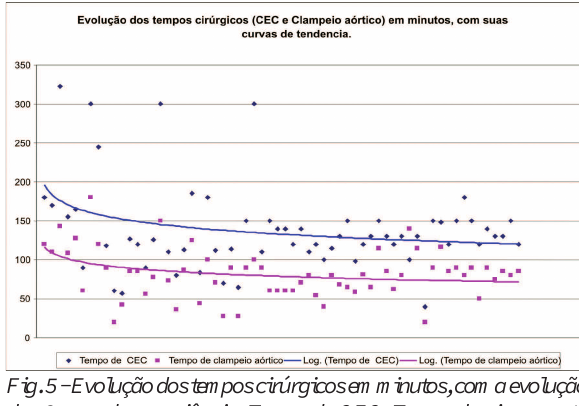
Fig. 5 - Evolução dos tempos cirúrgicos em minutos, com a evolução dos 6 anos de experiência. Tempo de CEC, Tempo de pinçamento aórtico e tempo de sala cirúrgica em minutos, com suas curvas de tendência (linha x com cada caso, seguindo os quatro anos de experiência com